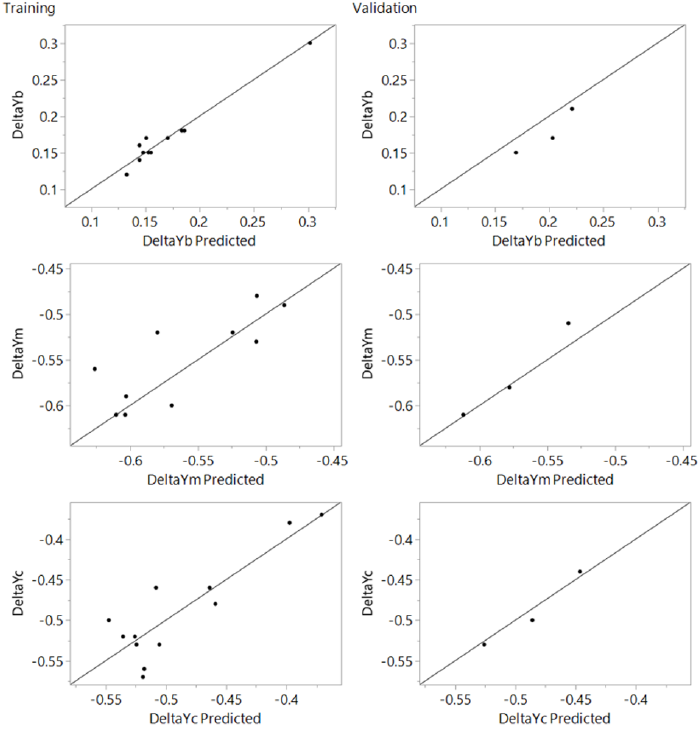
Figure 12. Actual by predicted plot for training and validation for the mesh size of 1 × 1 mm.